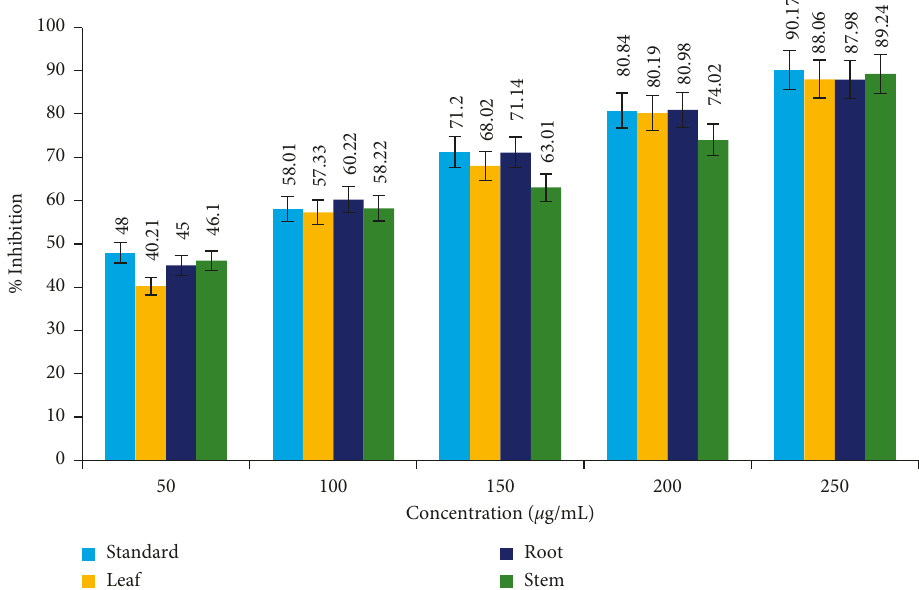
Figure 4: Anti-inflammatory activity of C. lanatum with the standard (acetyl salicylic acid).